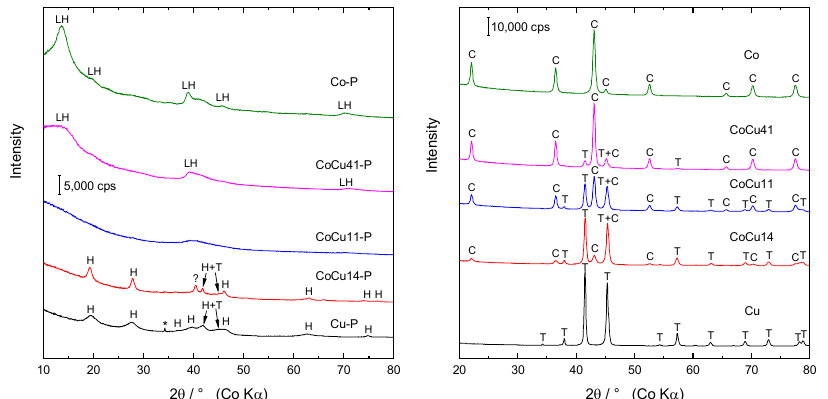
Figure 1. Powder XRD patterns of the coprecipitated precursors ( left ) and oxide catalysts obtained after calcination at 500 ◦ C in air ( right ). H–Cu(OH) 2 , LH–hydrotalcite-like layered hydroxide, *—NaNO 3 , ?—unidentified, C—Co 3 O 4 , T—CuO (tenorite).